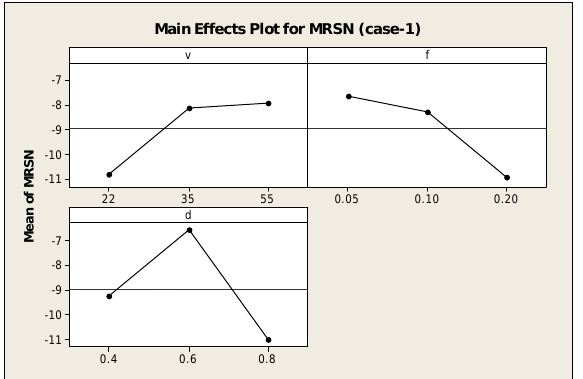
Fig. 4 . Main effect plot for MRSN (case-1) Fig. 5. Main effect plot for MRSN